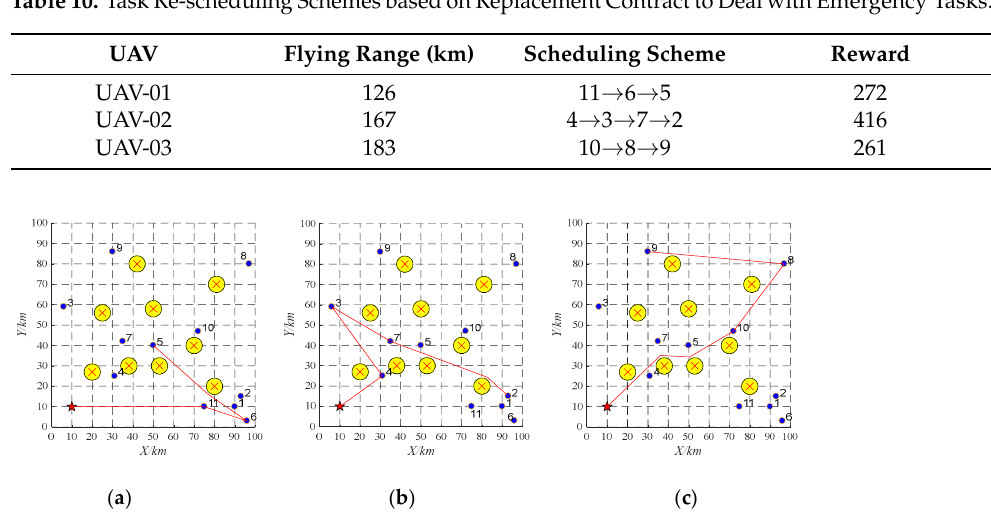
Figure 10. Task re-scheduling schemes with the emergency task based on replacement contract. ( a ) UAV-01; ( b ) UAV-02; ( c ) UAV-03.